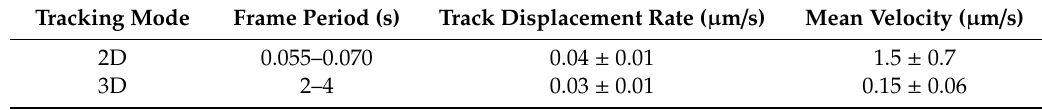
Table 2. 2D vs. 3D comparison of translocating MFA2